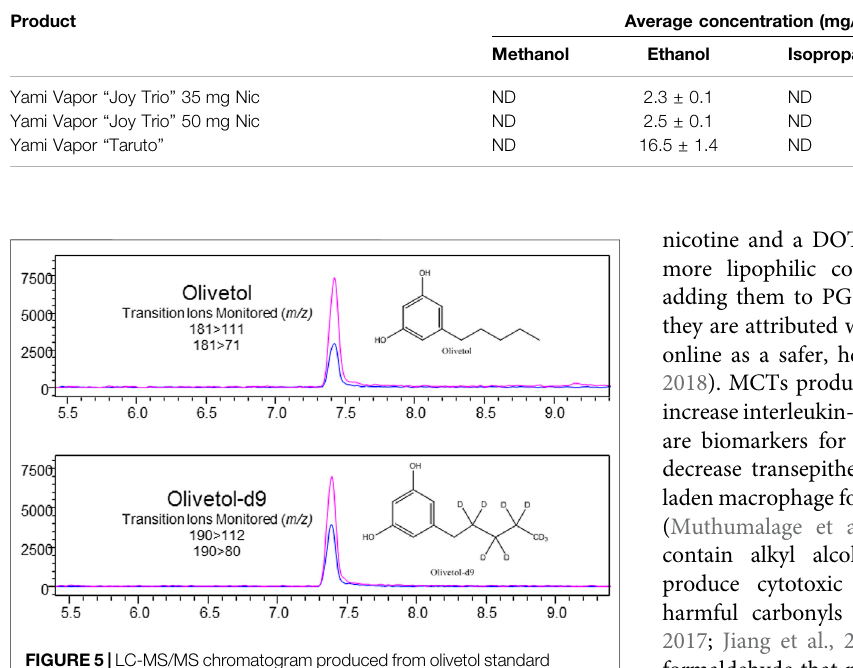
FIGURE5 | LC-MS/MS chromatogramproduced from olivetol standard (S3 – 500 ng/ml), with structures and transitions monitored for olivetol and olivetol-d9.